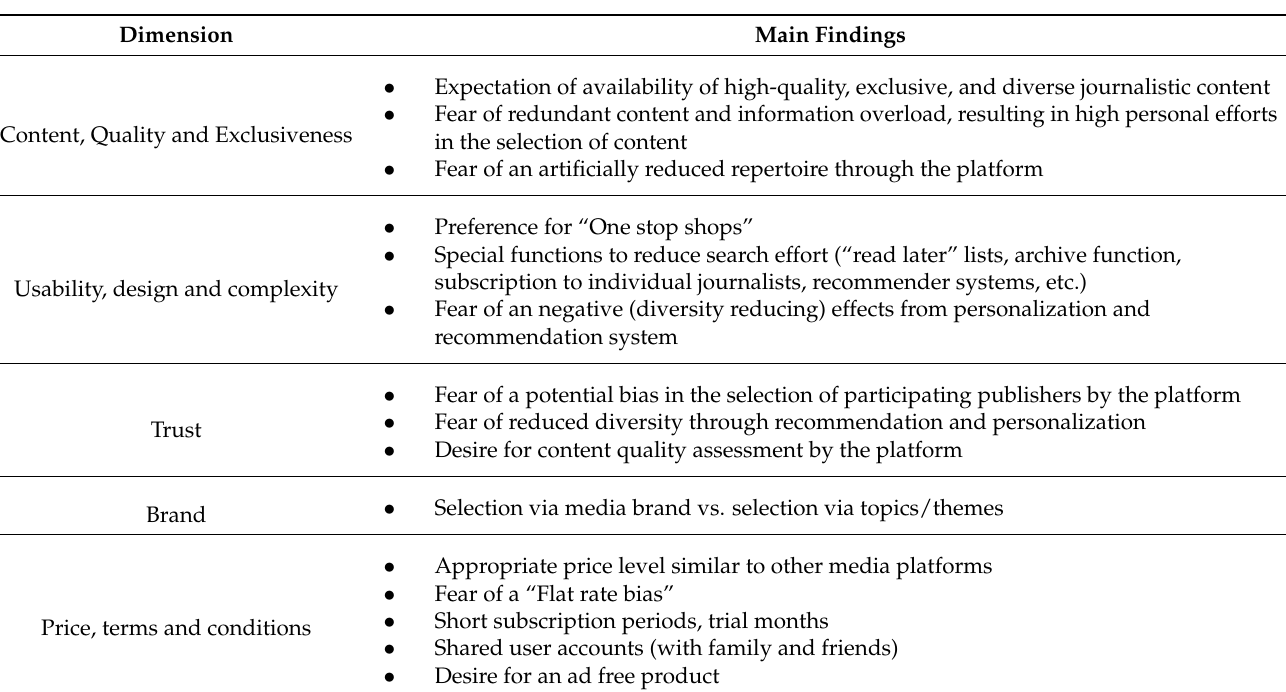
Table 2. Perception and expectations of subscription-based news platforms by participants in the group